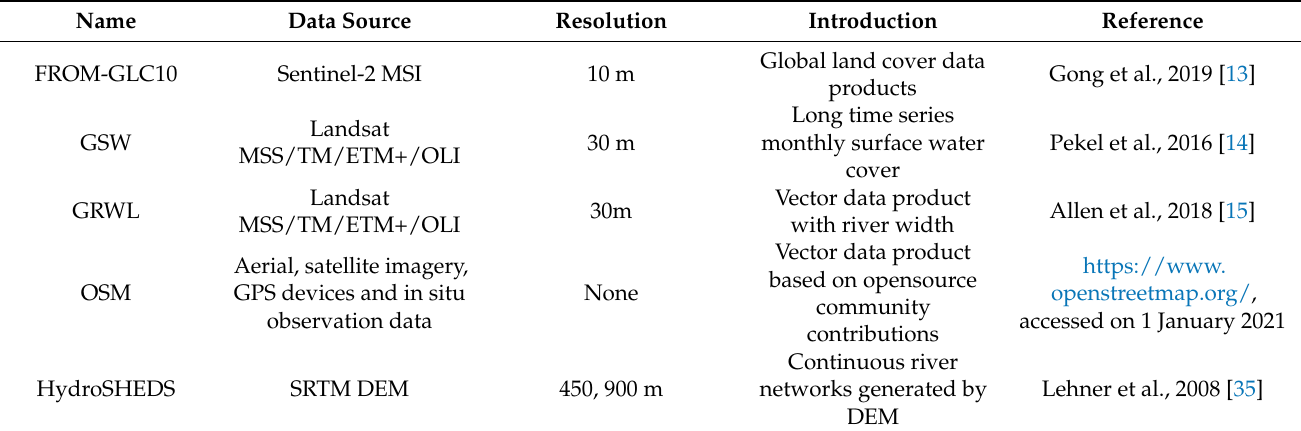
Table 1. Existing river network remote sensing